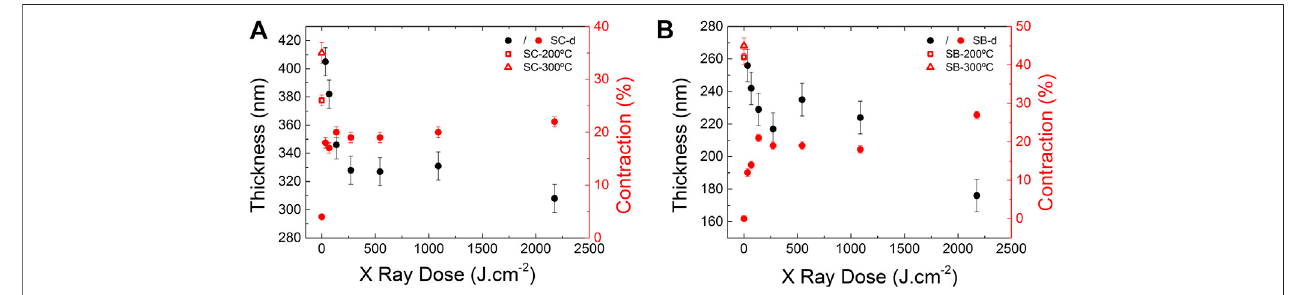
FIGURE 4 | Contraction of the pore structure (red symbols) and macroscopic thickness reduction (black symbols) as a function of the XR dose, and for thermally treatedsamples,in (A) SCand (B) SBsystems.Thevaluesofcontractionmeasuredforthermallytreated fi lmsat200 ° C(squares)and300 ° C(triangles)arealsoincluded.